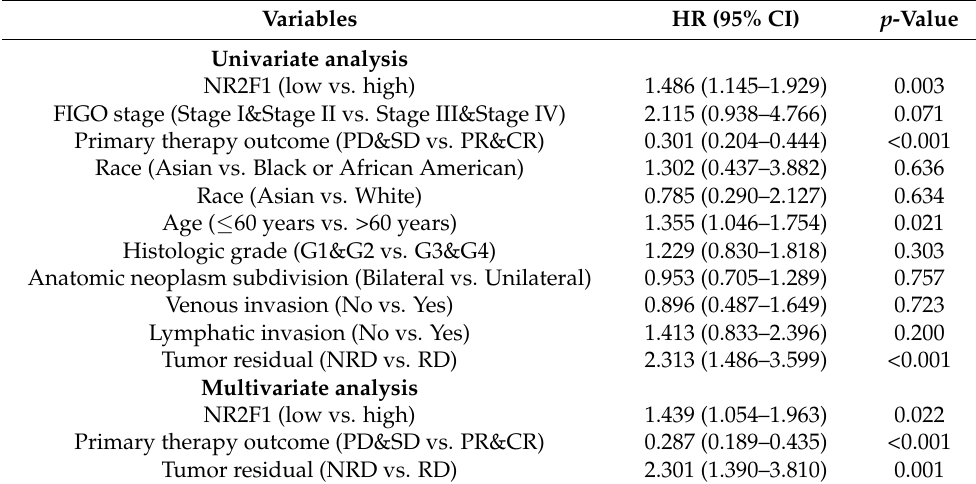
Table 1. Univariate and Multivariate analysis of risk factors and OS in